Question: Draft a figure caption describing what is shown.
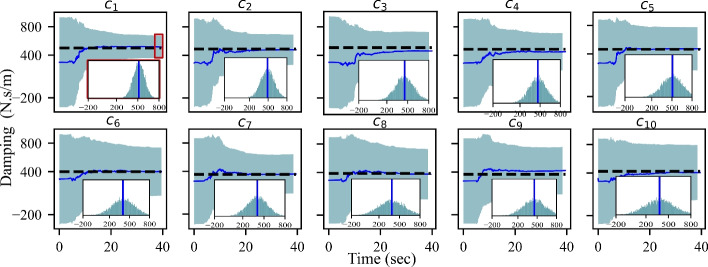
Answer: Time evolution of the estimated damping matrix terms corresponding to the ten DoF system: UKF-F5HP estimation (blue solid line); estimation uncertainty (grey area); ground truth values (black dashed line). Inset show the histogram of the last time step estimated parameter for each DoF, taking uncertainty into account